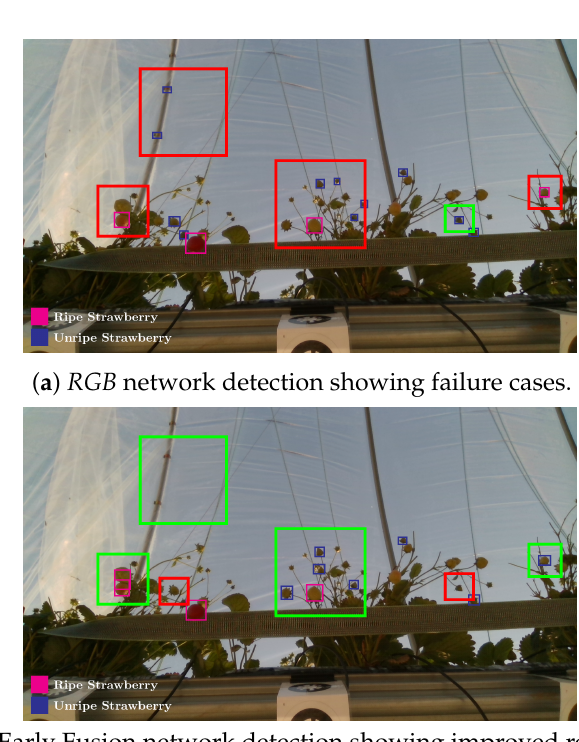
Figure 9. Performance on difficult input: Early Fusion and RGB models evaluated on V 3 , the view with the highest spatial variation. The early fusion approach maintains detection accuracy over huge illumination and shape alterations (introduced from viewpoint). Improved results are shown in green and detrimental results shown in red.